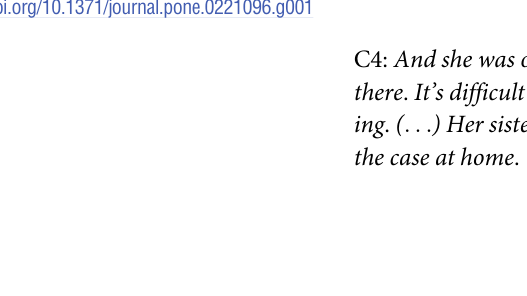
PLOS ONE | https://doi.org/10.1371/journal.pone.0221096 August 14,